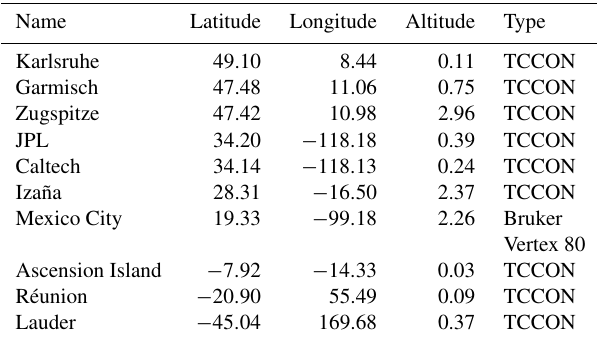
Table 1. Ground-based FTS stations used for validation. The lati- tude and longitude values are given in degrees, the surface elevation in